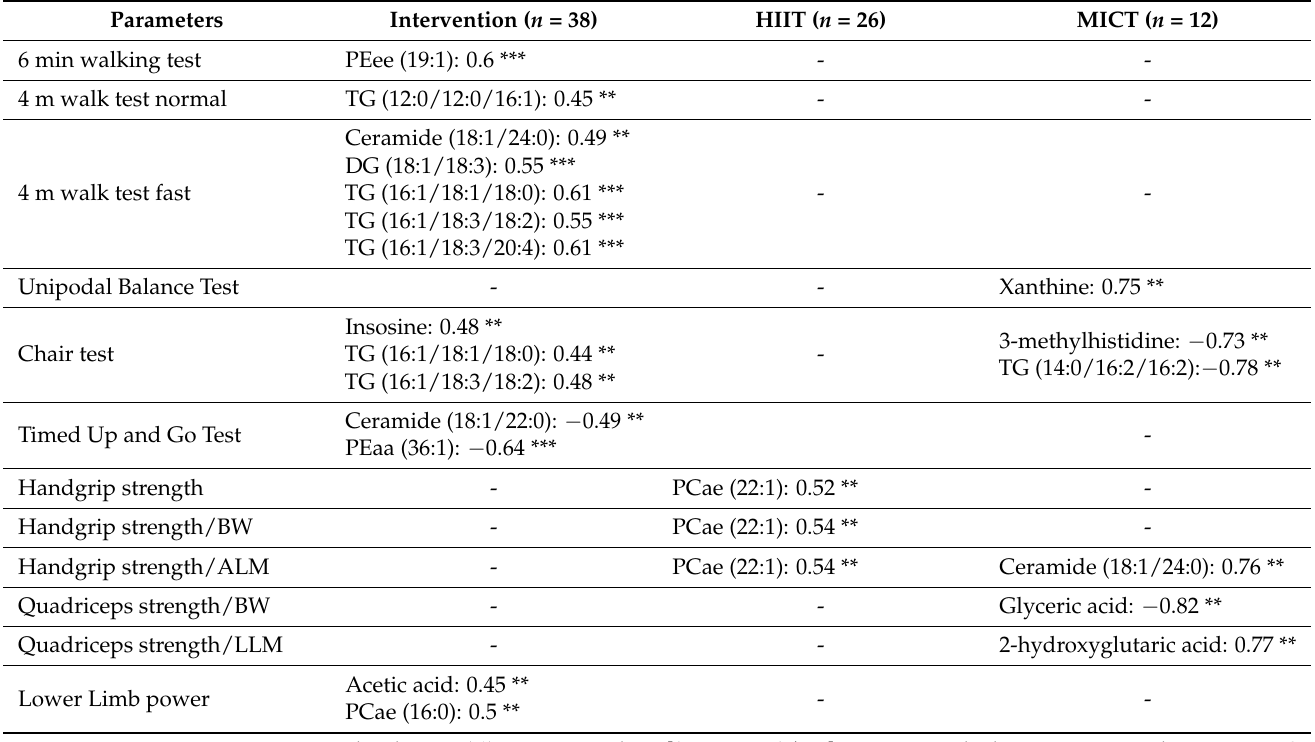
Table 4. Significant correlations between functional capacities as well as muscle strength parameters delta changes and significant metabolites delta